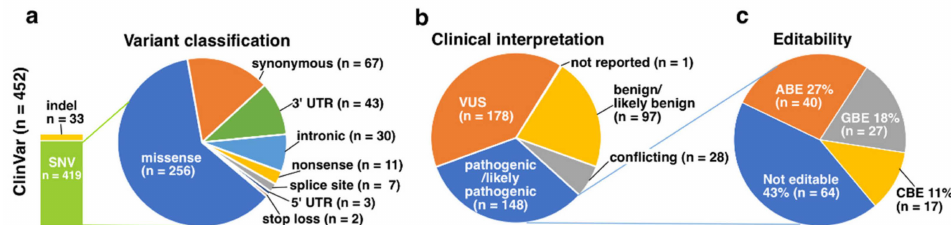
Figure 3. Graphical illustration of the ClinVar dataset. ( a ) Altogether 452 unique RHO variants have been reported to ClinVar, with SNVs forming the largest proportion of them with 93% share. Again, the most common variant type was missense variants, which covered over 61% or all the reported unique SNVs. ( b ) Clinical interpretation was reported for all but one of the variants, and 33% were labeled as pathogenic or likely pathogenic. ( c ) Of the pathogenic or likely pathogenic variants, 57% could be edited with ABE, CBE or GBE, with ABE being again most frequently usable option.